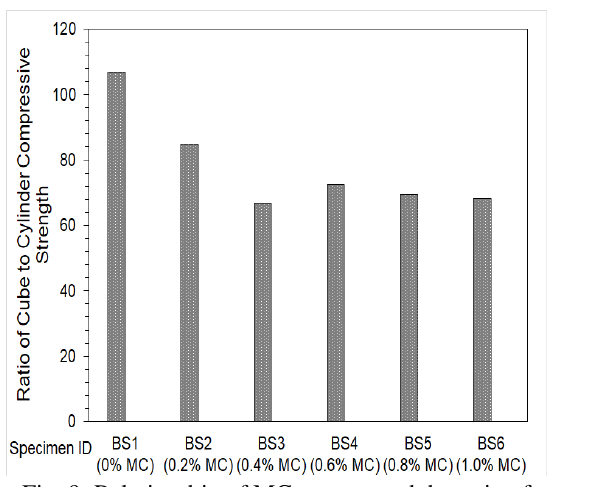
Fig. 10: Comparison of increase in compressive strength of concrete cubes and cement mortar